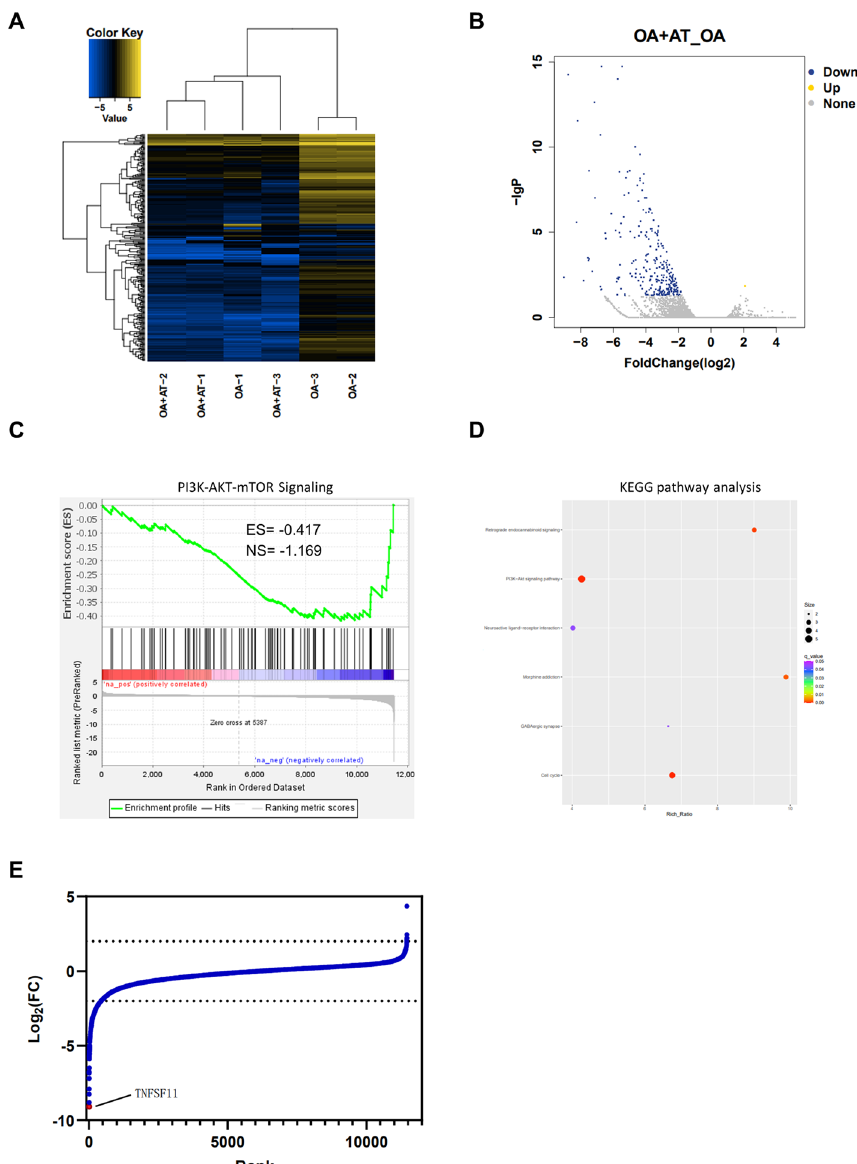
Fig. 2 Transcriptomic and gene enrichment analysis upon AT treatment in OA chondrocyte cells. A Heatmap of expression of transcripts from triplicate experiments of OA and OA AT. B Volcano plot of differential + expressed genes. Yellow points represent upregulated genes for log 2 FC > 2, and blue points represent upregulated genes for log 2 FC < -2. C GSEA analysis of negative regulated genes shows PI3K–AKT–mTOR signaling. D The analysis of KEGG pathway enrichment for negative regulated genes. P13K-AKT-mTOR signaling pathway was enriched from these negative regulated genes. E Waterfall plot of fold change in gene expression in OA chondrocyte cells treated with 0.05 µM AT for 6 h; selected TNFSF11 gene is